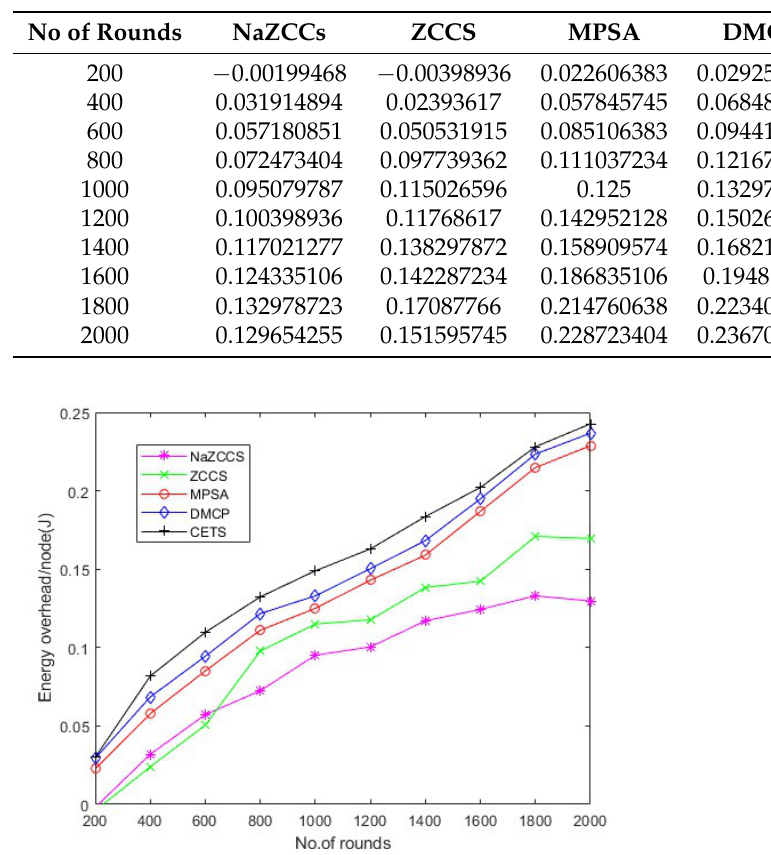
Figure 16. CETS versus other models on energy overhead per round at hop density